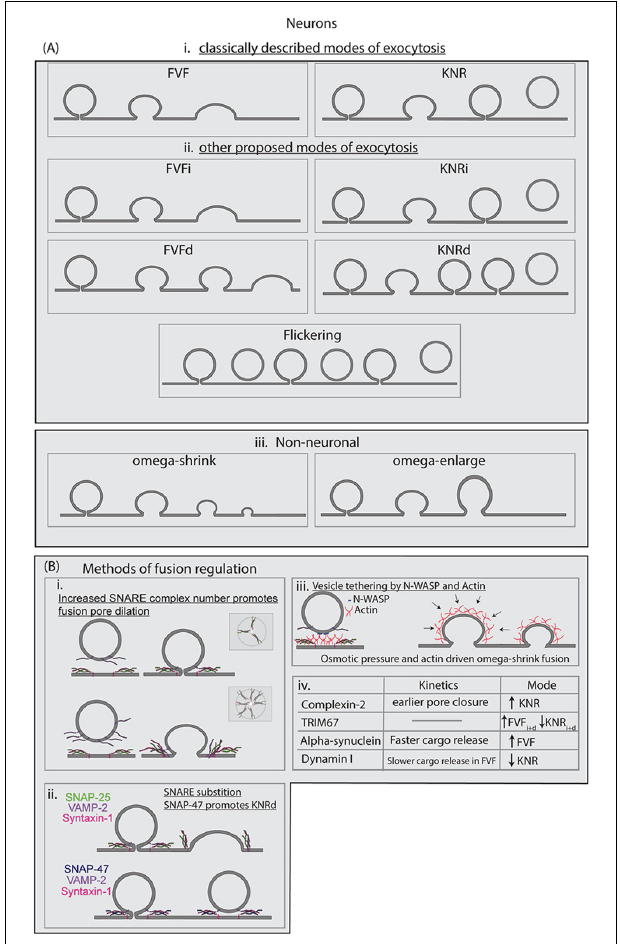
FIGURE 3 | (A) Modes of exocytosis described in the literature for neuronal and non-neuronal cells. Full-vesicle fusion (FVF) and KNR were the first proposed modes of exocytosis. Recently we proposed the subclasses of FVFi, FVFd, KNRi, and KNRd to best describe the heterogeneity observed in developing cortical neurons. Flicker fusion has been observed at hippocampal synapses, resulting in the vesicle retreating from the membrane. In neuroendocrine cells, omega-shrink and omega-enlarge have been described as the primary modes of exocytosis observed. (B) Known regulations of SNARE-mediated fusion are described, including regulation of the modes of exocytosis. (i) The number of SNARE complexes at the fusion pore increases the probability of fusion pore opening and accelerates fusion pore expansion. (ii) SNARE-substitution can alter fusion dynamics, such as SNAP-47 substituting for SNAP-25. SNARE complexes made up of different SNAREs have distinct kinetic profiles. (iii) Spatial segregation or aggregation, such as linking of vesicles to the plasma membrane by N-WASP, can regulate fusion. Actin dynamics also regulate fusion dynamics, and actin as well osmotic pressure is suggested to drive FVF as well as omega-shrink fusion in neuroendocrine cells. (iv) A limited list of proteins suggested altering modes of fusion and the kinetics of SNARE-mediated fusion in